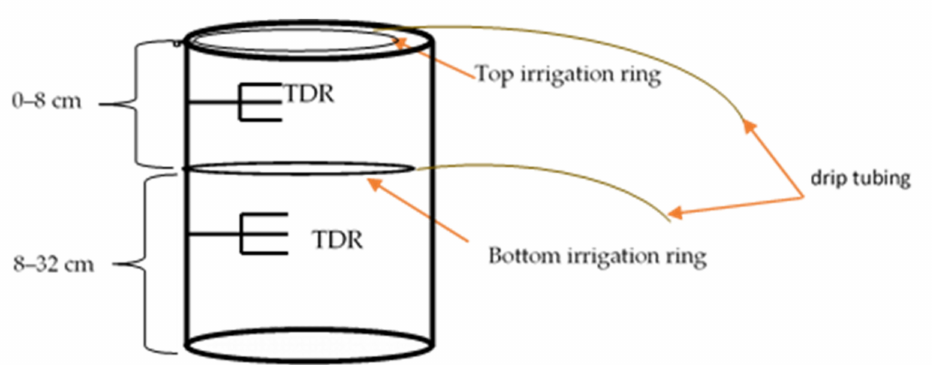
Figure 1. Stratified phosphorus pot system. Top 0–8 cm and bottom 8–32 cm, horizons separated by a dribble ring pressure compensated with 10.2 cm diameter, connected to 30.5 cm length drip tube. The figure was recreated from Ho et al. [9] and is not drawn to scale. TDR: time domain